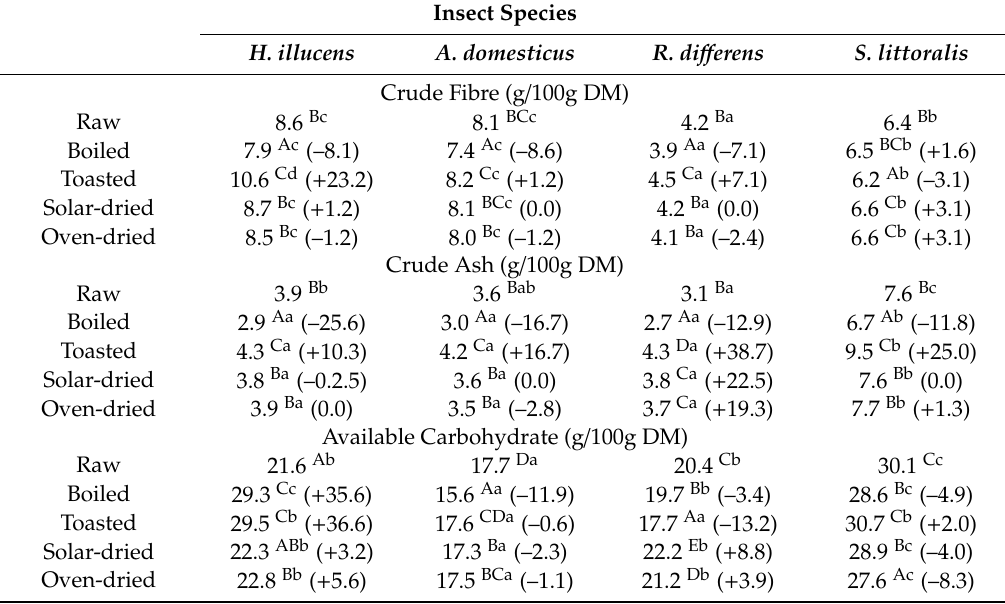
Table 2. Crude fibre, ash and carbohydrate contents of raw and processed